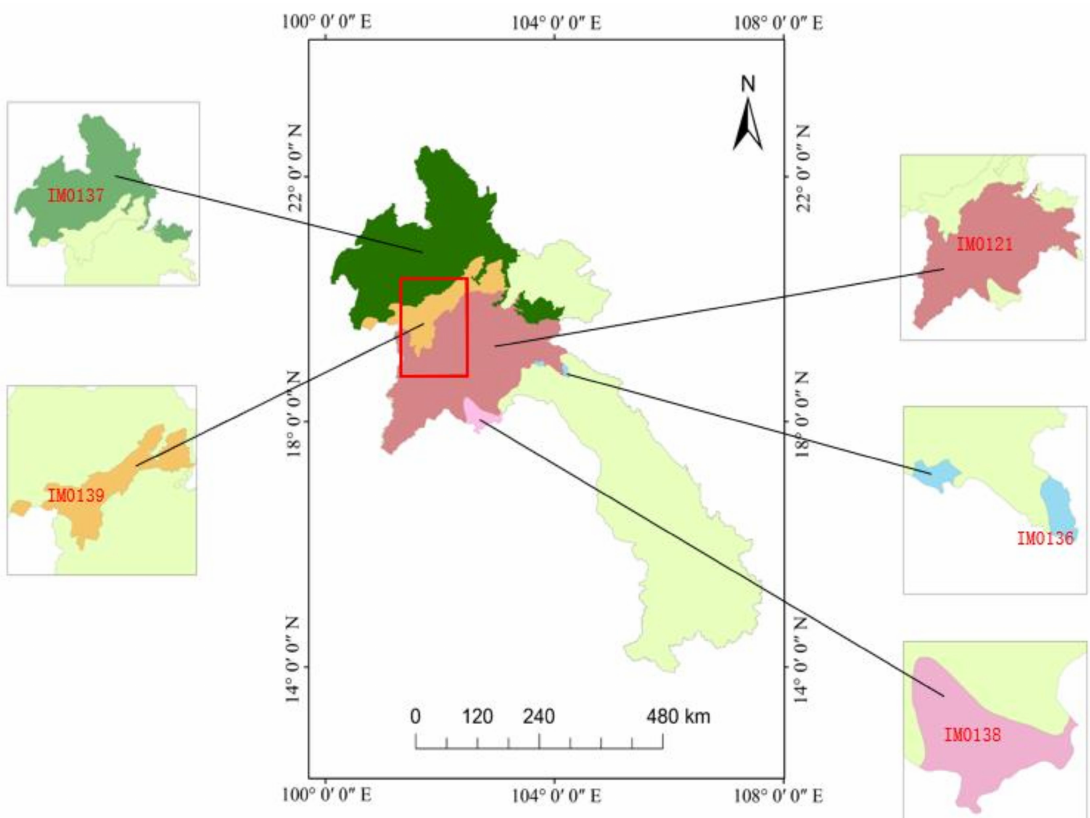
Figure 9. Eco-geographical zoning of the experimental area, where the red box is the study area. The study area consists of three eco-geographical zones, namely the Luang Prabang montane rain forests (IM0121), the northern Indochina subtropical forests (IM0137),